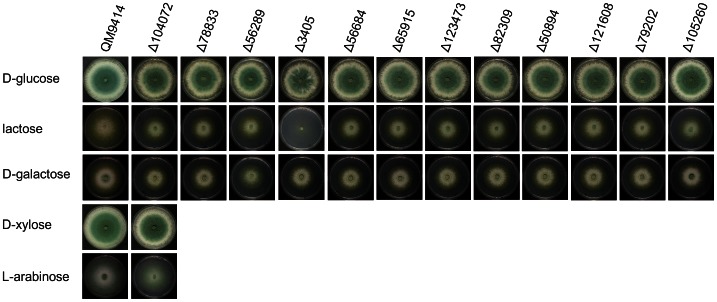
Growth of several MFS-knock out strains on D-glucose, lactose, D-galactose, and where appropriate, D-xylose, and L-arabinose.Pictures were taken 96 h after of incubation on minimal medium supplemented with the appropriate carbon source (1% w/v).